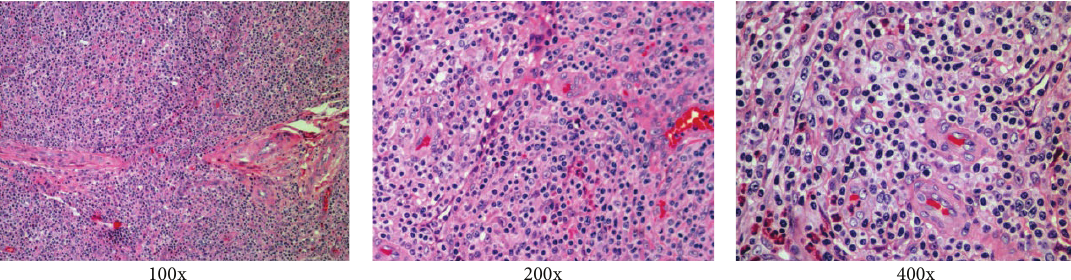
Figure 1: Pathology of AITL. The pathology slides were stain of H&E by standard procedure. Pathology of AITL was shown separately (100x, 200x, and